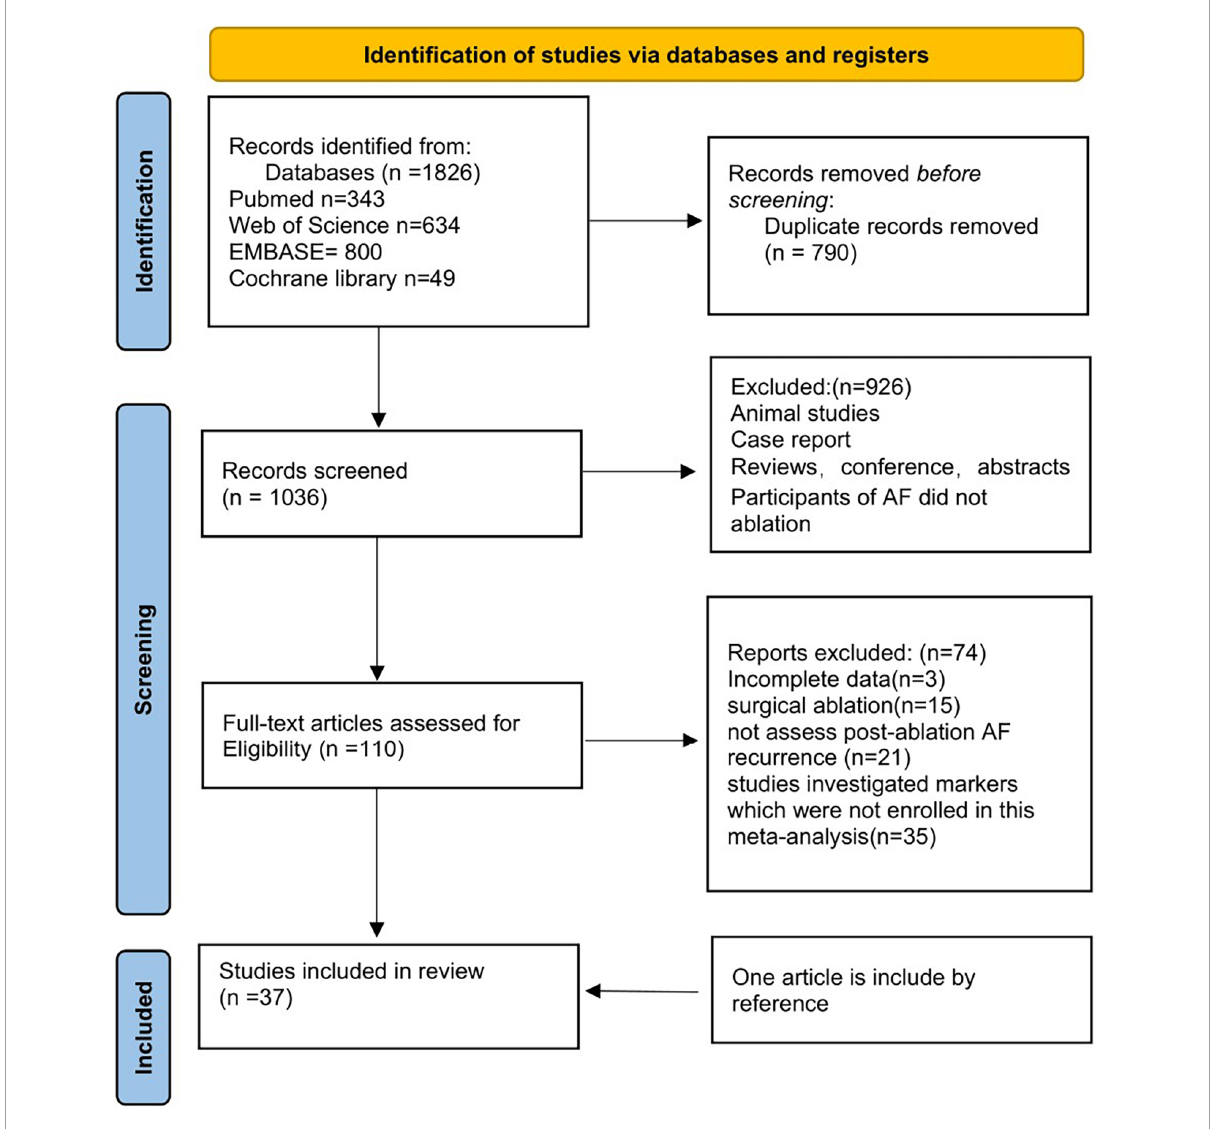
FIGURE1 Summary of electronic search and included/excluded